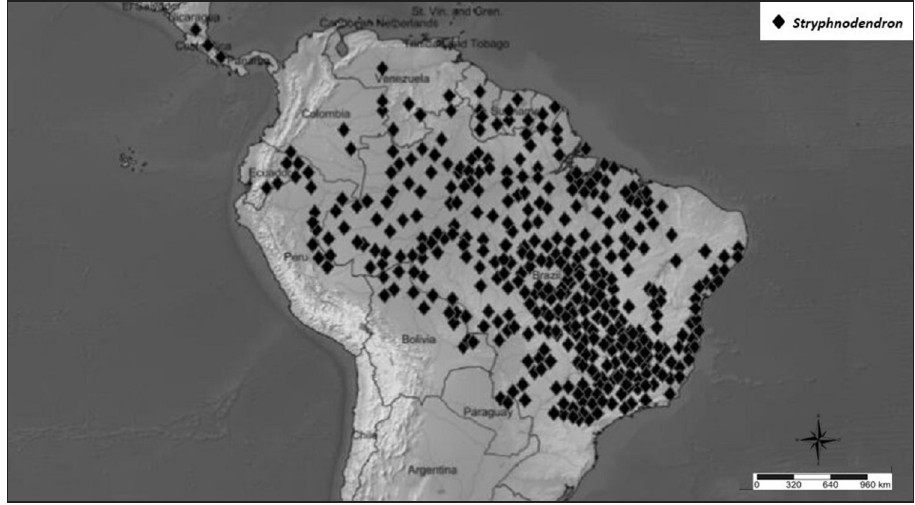
Figure 10. Distribution of Stryphnodendron